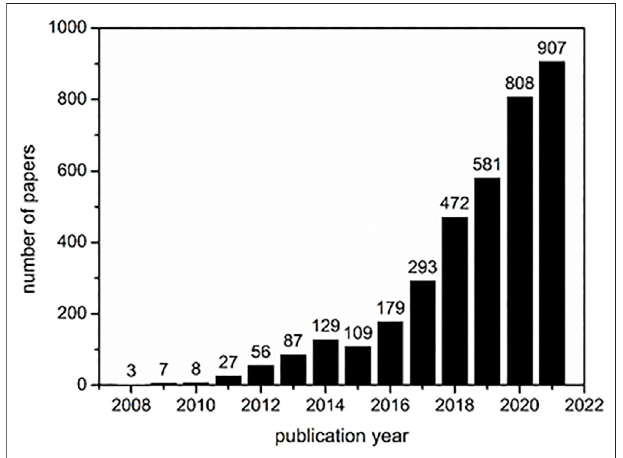
FIGURE1| Numberofpapersthatincludesthekeywords “ cyclodextrin